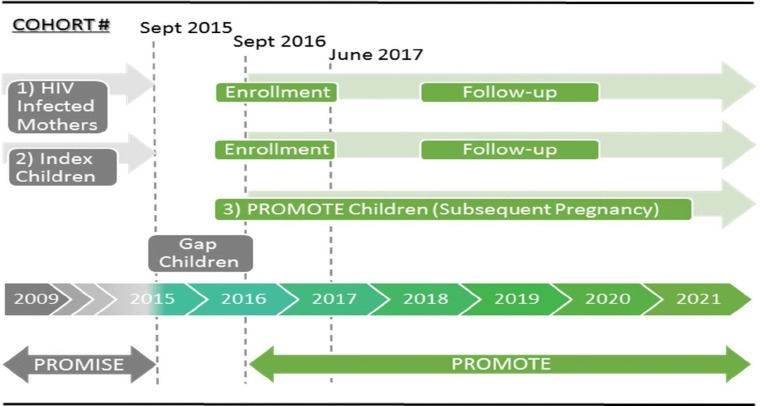
PROMOTE Study populations, enrollment and follow-up.